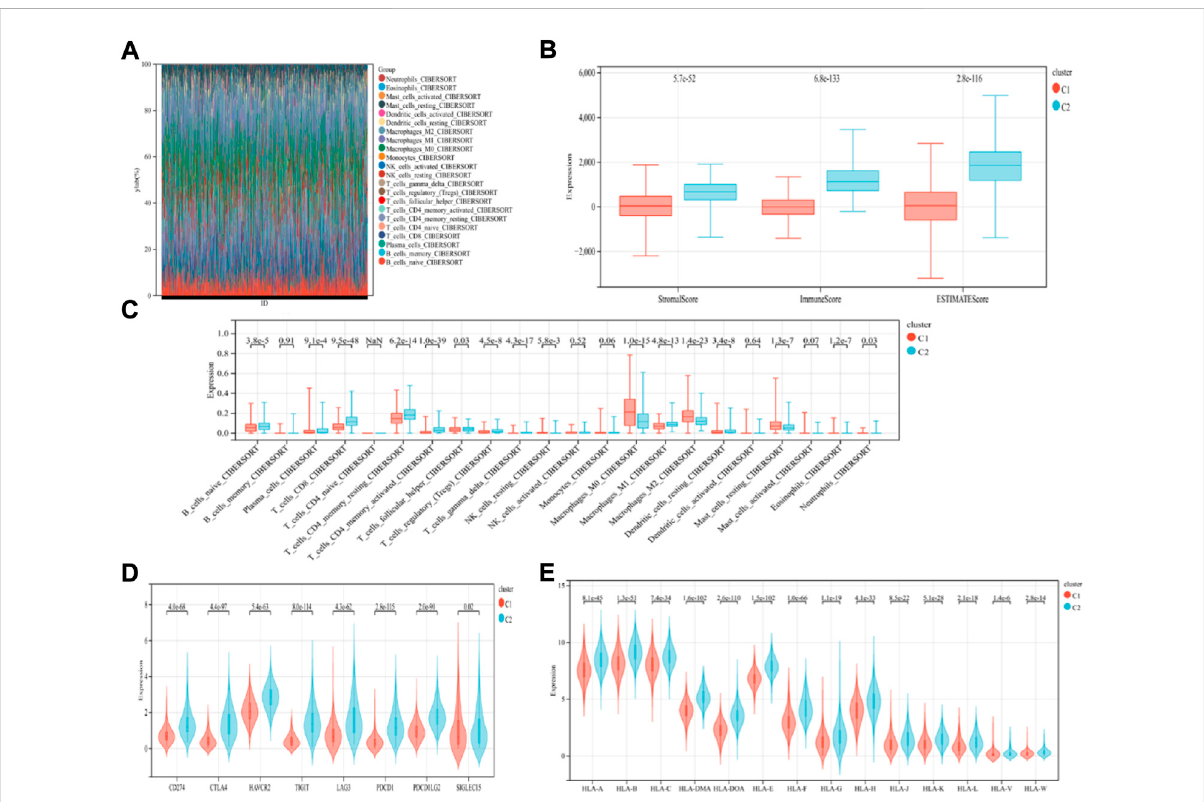
FIGURE 4 Immunological pro fi les of the different ICD subcategories. (A) Relative Proportion of the in fi ltration of immune cells in the ICD-low and ICD- high subcategories; (B) Stromal, Immune, and Estimate scores in the ICD-low and ICD-high subcategories; (C) The signi fi cant variations in the in fi ltration of immune cells in both subcategories; (D,E) The differential expression of numerous immune checkpoint genes (D) ; and the HLA genes (E) , in the 2